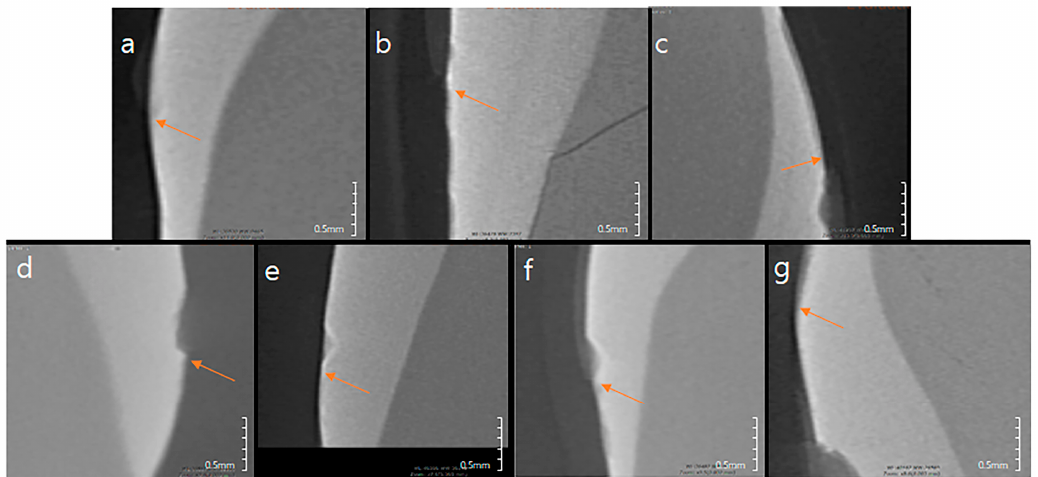
Figure 7. Remineralization point of the BAG and ion (silver or zinc)-doped BAG orthodontic bonding primer via CBCT. ( a ) Control; ( b ) BAG 0.2%; ( c ) BAG 1.0%; ( d ) BAG@Ag1 0.2%; ( e ) BAG@Ag1 1.0%; ( f ) BAG@Zn5 0.2%; and ( g ) BAG@Zn5 1.0%.